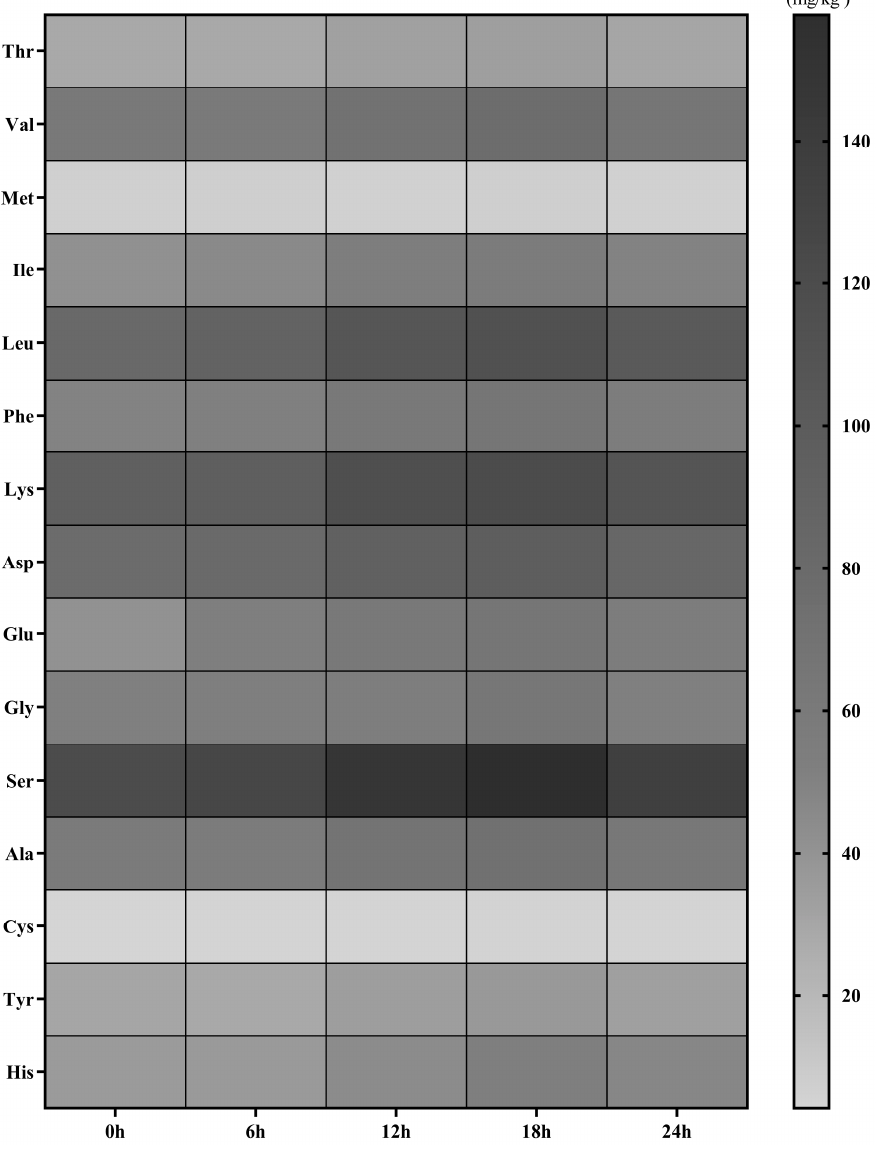
Figure 3. Heatmap of amino acid content in fermented sausage at different